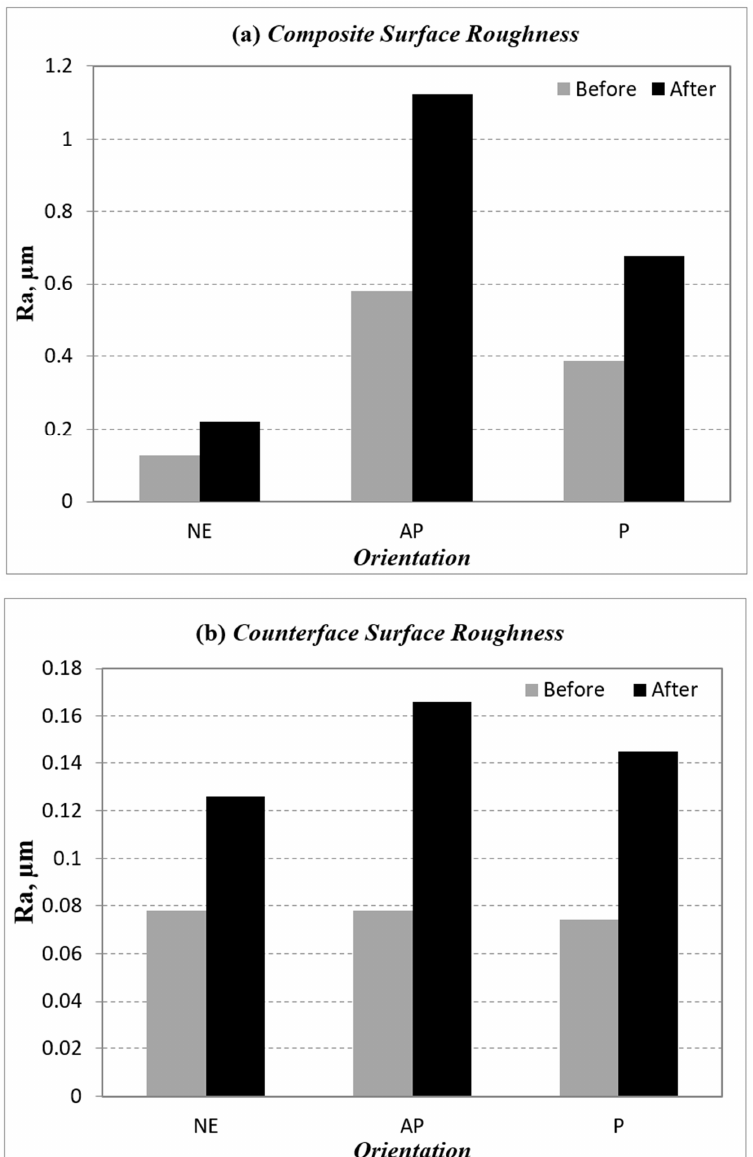
Figure 12. Composite and counterface surface roughness for different fibre orientation (AP and P) and neat